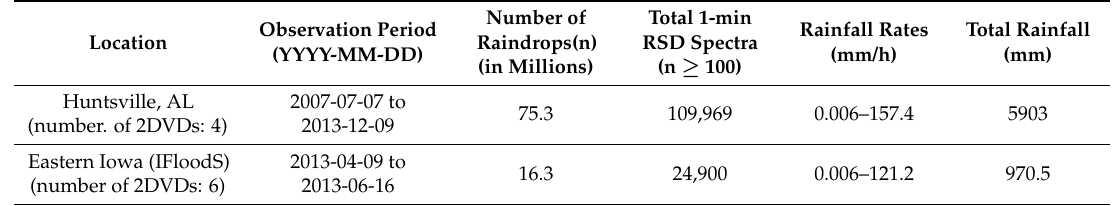
Table A1. Overview of 2DVD rainfall measurements collected at Huntsville and IFloodS. This summary includes measurements from multiple 2DVDs when present at the same